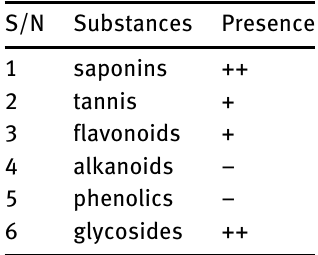
Table 2: Phytochemical constituents of RSE.